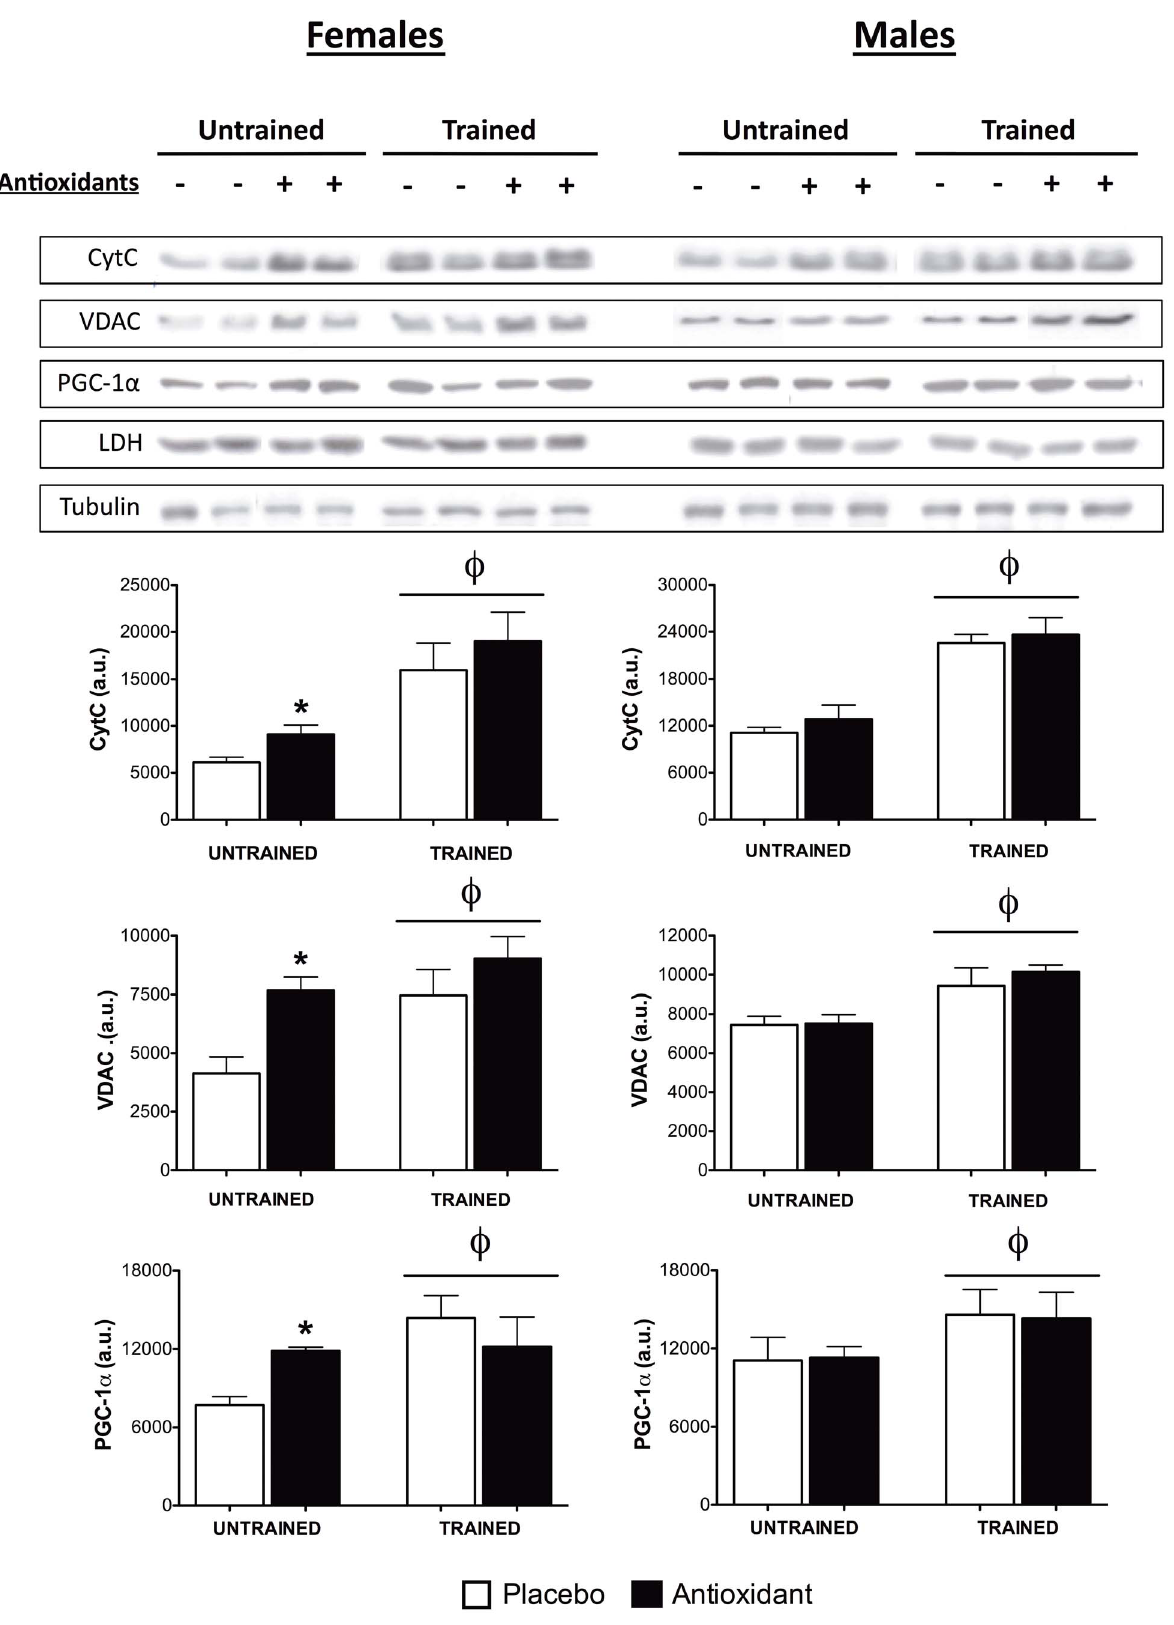
Figure 3. Expression of mitochondrial proteins and PGC-1 a . Expression of mitochondrial proteins and PGC-1 a were determined using Western blotting on protein homogenates prepared from tibialis anterior muscle tissue (n=4–6 mice/gender/group). Data are means 6 SEM and representative bands from each gender and group are shown. w indicates main effect of training, p # 0.05, and post-hoc testing was used to compare antioxidant- and placebo-supplemented groups, * indicates p # 0.05. doi:10.1371/journal.pone.0060722.g003 PLOS ONE |